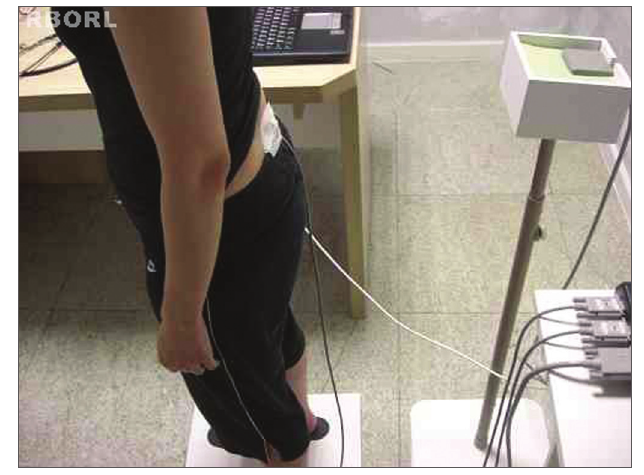
Figura 2. Sensor fixado entre S1 e